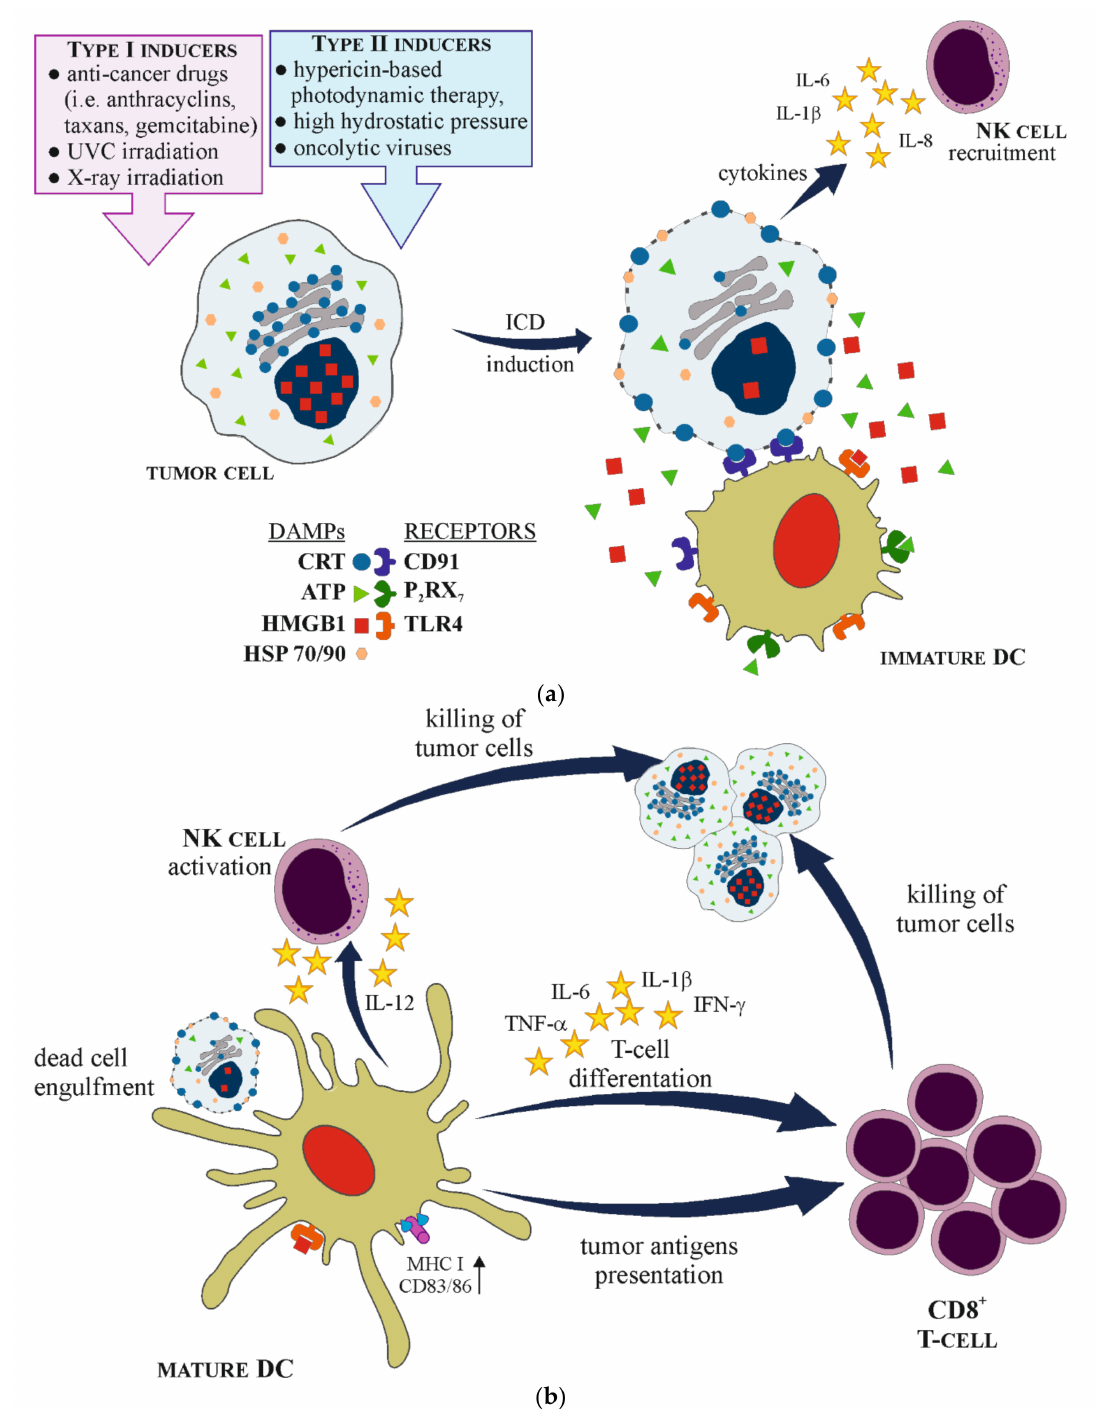
Figure 1. Schematic presentation of immunogenic cell death (ICD) mechanism. ( a ) ICD is induced after the exposure of tumor cell to type I or type II ICD inducers. Dying tumor cell releases and exposes on its plasma membrane different damage associated molecular patterns (DAPMs) molecules that are recognized by specific pattern recognition receptors (PRRs) on immature dendritic cells (DCs), leading to their maturation and activation. Additionally, tumor cells secrete cytokines that recruit natural killer (NK) cells. ( b ) Mature DC engulfs dying tumor cell, processes tumor antigens and presents it along with major histocompatibility complex (MHC) class I and costimulatory molecules (CD83/86) to CD8 + T-cells. Moreover, mature DCs secrete a range of cytokines that promote T-cells differentiation into CD8 + phenotype, as well as activate NK cells. Finally, activated NK cells and CD8 + T-cells are able to kill tumor